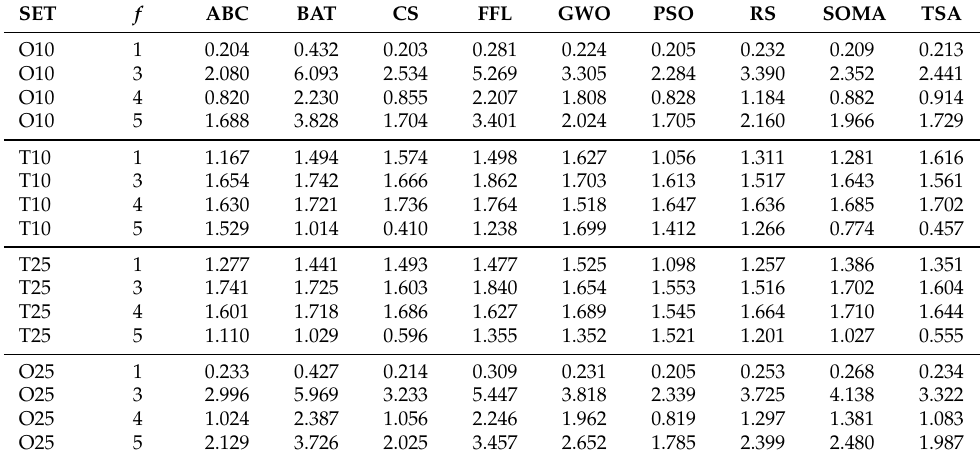
Table 16. The median values for each algorithm and each